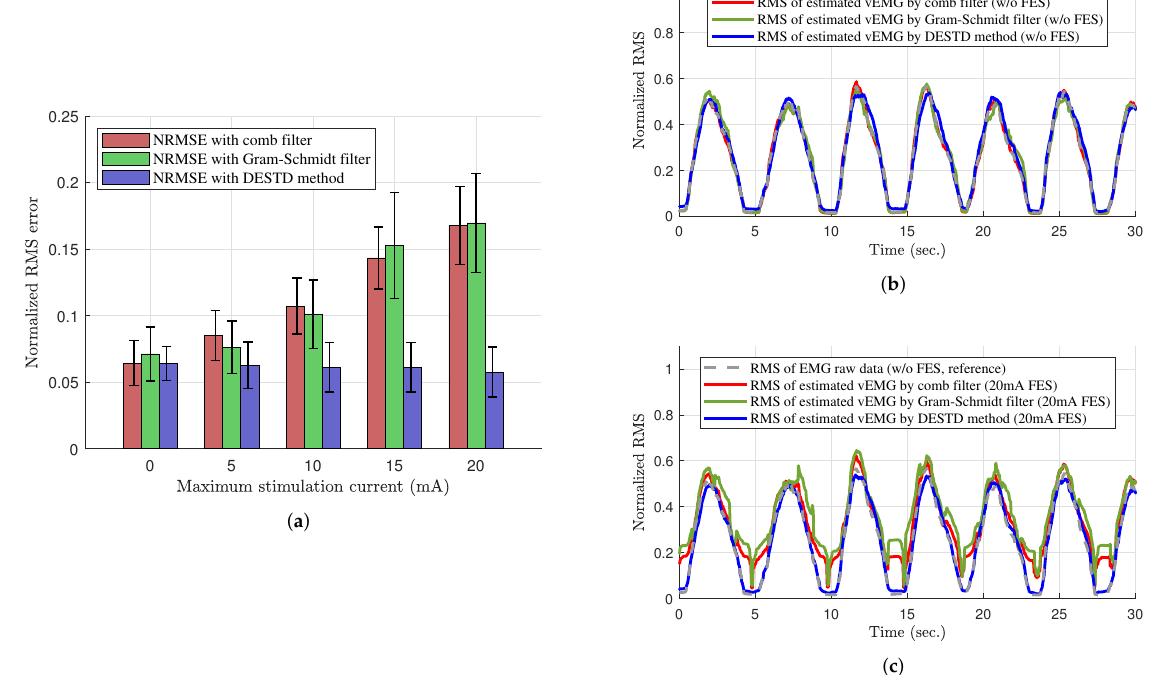
Figure 8. Performance of removing the FES-induced signals of the comb filter, Gram–Schmidt filter, and DESTD method. ( a ) NRMSE values of the estimated vEMGs; ( b ) RMS values of the estimated vEMGs without FES; and ( c ) those with FES of 20mA maximum stimulation current using the comb filter, Gram–Schmidt filter, and DESTD